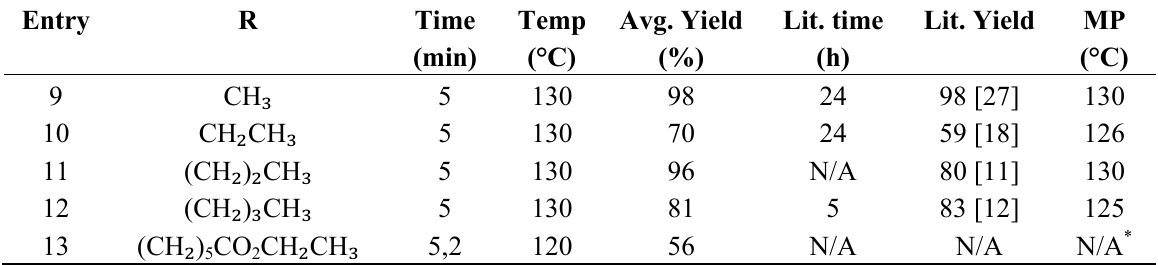
Table 2. Synthesis of quinolinium deriviatives (Biotage Initiator